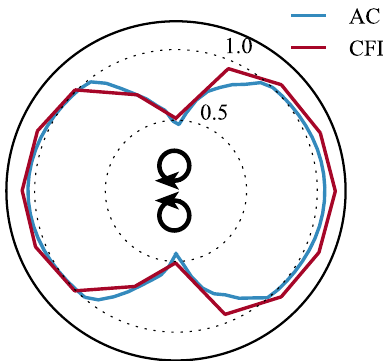
Figure 14. Normalized power as a function of wind direction on a polar plot, with an overlay of the turbine rotation directions. Results shown for both the actuator cylinder method (AC) and the CFD re- sults of Zanforlin and Nishino